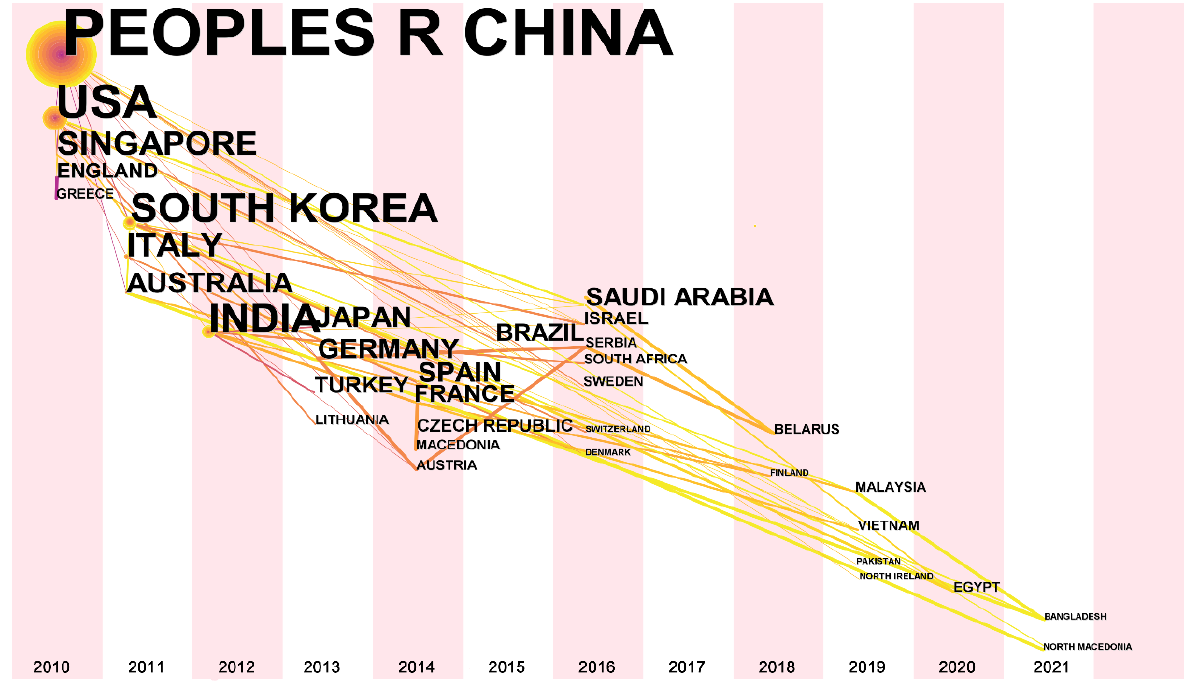
Figure 6. A time ‐ zone view of geographic distribution for graphene ‐ based SERS. Figure 6. A time-zone view of geographic distribution for graphene-based SERS.